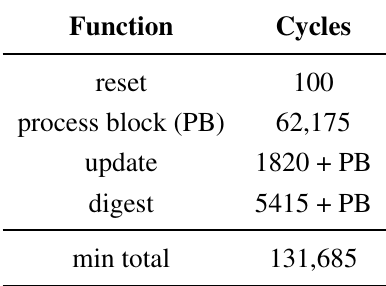
Table 4. Cycles for SHA-1 functions, assuming full 512-bit